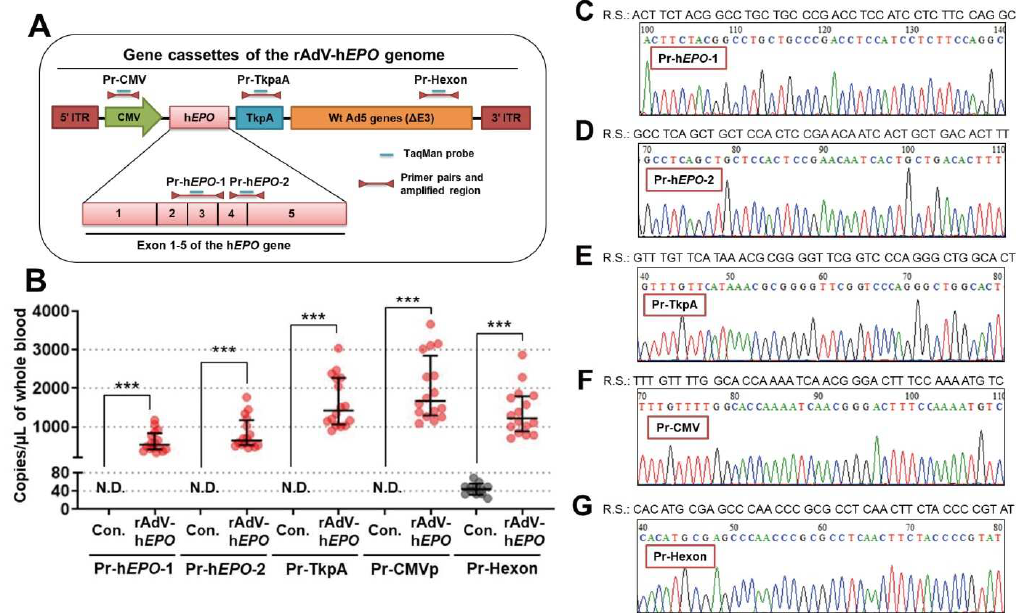
Figure 2. Direct proof in whole-blood DNA from AdEPO mice. ( A ) Strategy for designing specific primer-probe pairs for the viral genome. “Pr” indicates a primer-probe pair. ( B ) Detection of direct proof using the TaqMan qPCR assay performed with whole-blood DNA from the control ( n = 12) and AdEPO mice ( n = 15). ( C – G ) Sanger sequence analysis of the pooled amplicon on the TaqMan qPCR assay using five primer-probe pairs; R.S. indicates a reference sequence that completely matches the amplicon over 40 nucleotides on any primer-probe pair. N.D.: not detected. *** p < 0.001.